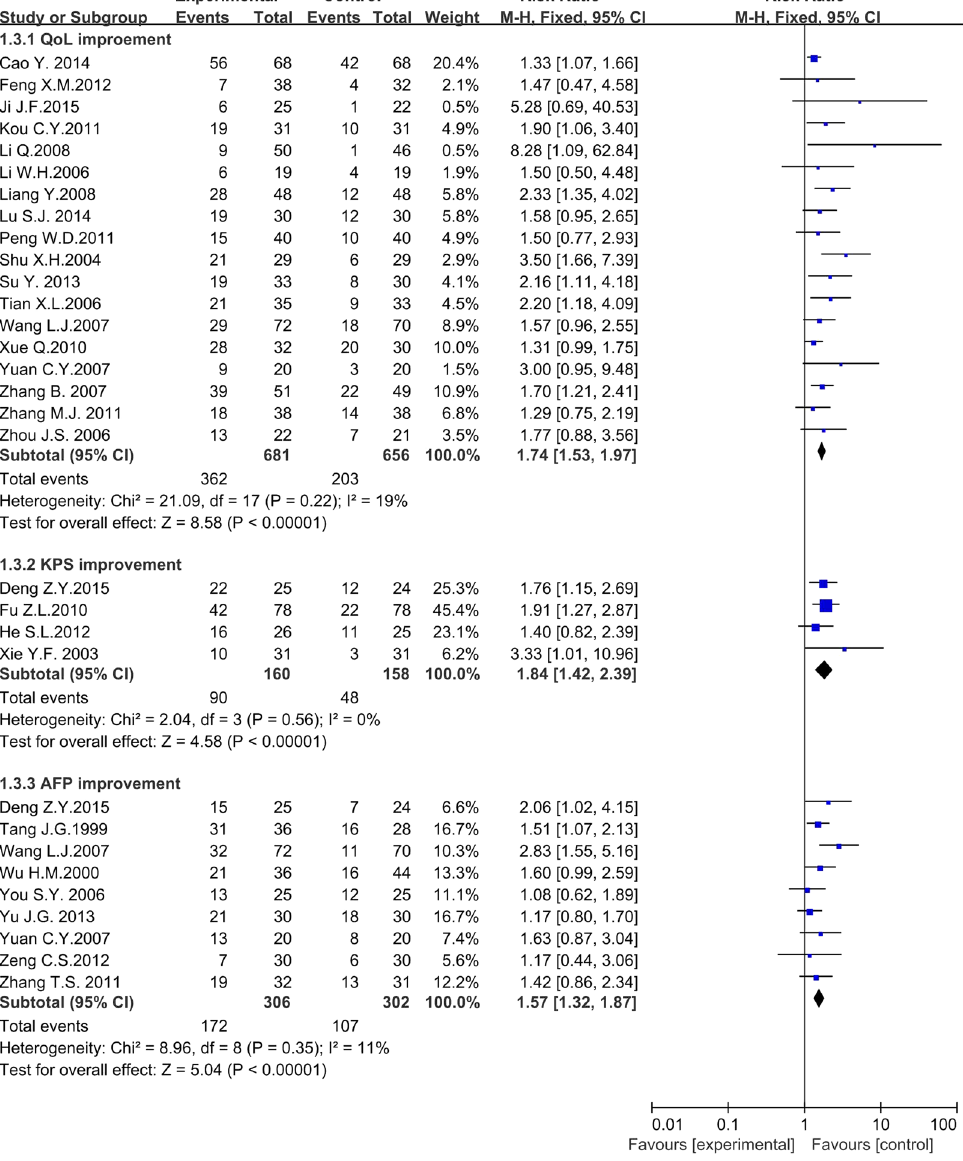
Eleven articles including 815 patients and 5 articles including 340 participants gathered information on liver damage 33, 34, 40, 51, 53, 67, 73, 78, 80, 81, 83 and kidney damage 53, 67, 78, 80, 83 respectively. The random effects model was performed to collect data for the liver damage group because the heterogeneity was high ( P < 0.001, I 2 = 92%). The subgroup analysis based on the drugs categories, publication years and experimental areas didn’t reveal the source of heterogeneity. The fixed effects model was conducted to collect data for kidney damage group because no obvious heterogeneity was found in the included articles ( P = 0.97, I 2 = 0%). The meta-analysis demonstrated that the liver damage and kidney damage in the experimental group were irrelevant to control group (liver damage: RR = 0.56, 95% CI = 0.31 to 1.02, P = 0.06 > 0.05; kidney damage: RR = 0.55, 95% CI = 0.24 to 1.27, P = 0.16 > 0.05). Ten articles including 621 patients 30, 37, 46, 51, 53, 57, 67, 69, 70, 85 and eight articles including 490 patients 30, 37, 42, 53, 64, 67, 70, 87 reported fever and pain respectively. They all used the random effects model for the reason of the obvious het- erogeneity ( P < 0.001, I 2 = 72%; P < 0.001, I 2 = 80%). We also didn’t find the source of heterogeneity through the subgroup analysis. The meta-analysis also showed both these two indexes in the treatment group and the